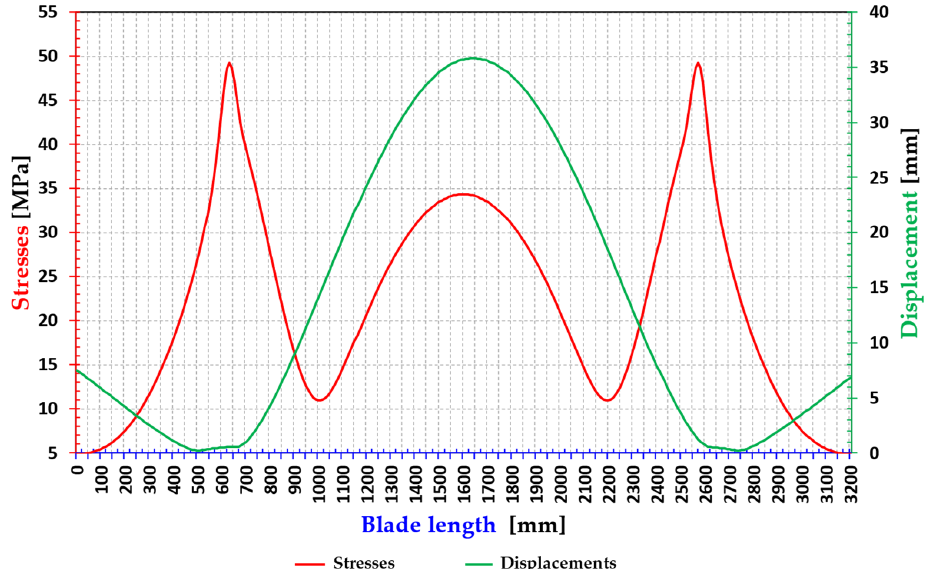
Figure 23. Maximum values of stresses and displacements at the point of application of maximum loads (c/4) of rotor blade 3 in V-Epoxy with the optimal thickness of 5 mm. Table 10. Evaluation of the maximum and minimum stress values on the selected path in case of critical load. Rotor 1 Rotor